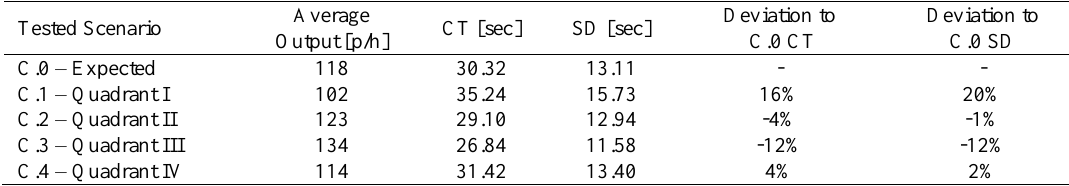
Table 6. Scenarios C results – 4 workers